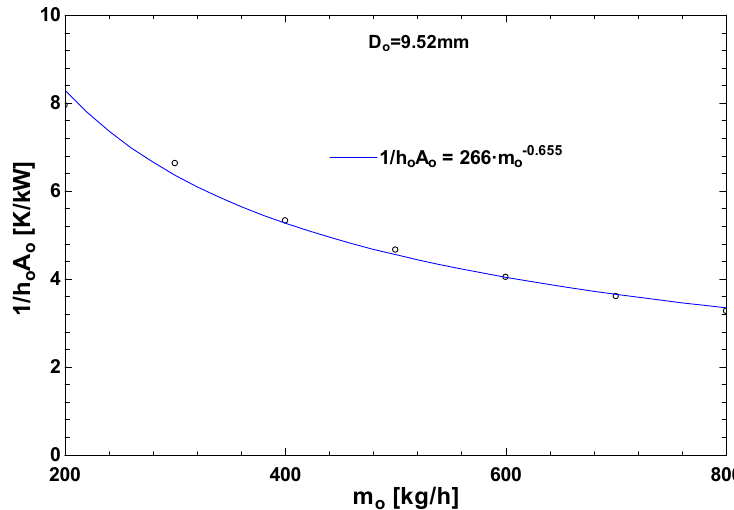
Figure 5. Annular side thermal resistance as a function of the water mass flow rate.